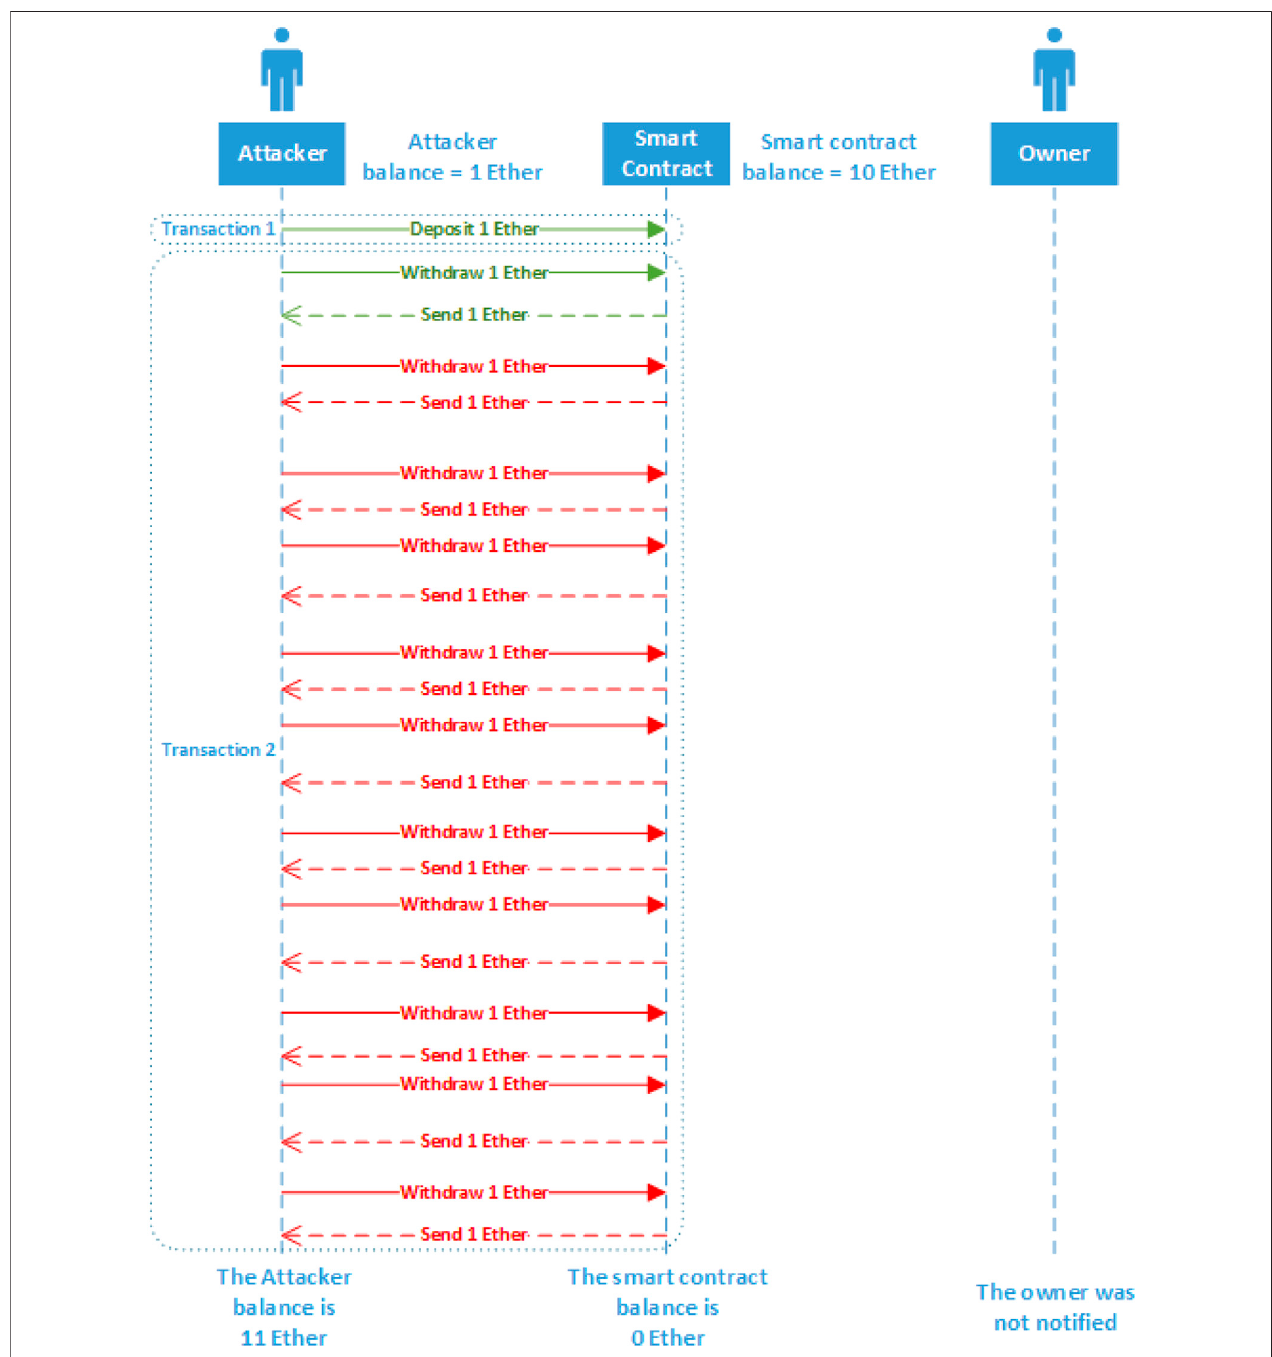
FIGURE 8 | UML sequence diagram for the fi rst scenario in the fi rst case